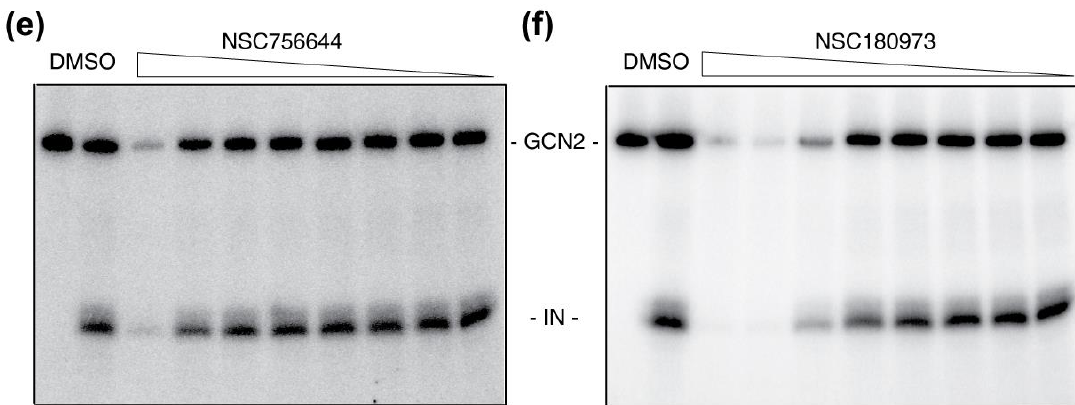
Figure 4. Effect of modulators on GCN2 and IN activities. ( a ) Effect of modulators on IN’s phosphorylation catalyzed by GCN2. Molecules were used at 100 µM corresponding to the initial screen concentration. ( b ) Effect of modulators on GCN2 auto-phosphorylation. The assay was conducted exactly as in panel ( a ) only without IN. Dose-response of active compounds in the phosphorylation assay. Representative images of SDS-PAGE resulting from an in vitro phosphorylation assay of IN catalyzed by GCN2 in the presence of NSC279836 ( c ), NSC758487 ( d ), NSC180973 ( e ), NSC756644 ( f ). First lane corresponds to GCN2 alone while lane two is with IN, both in the presence of DMSO as controls. Lanes three to ten correspond to the conditions with both IN and GCN2 in the presence of decreasing concentrations of molecules from 300 µM to 137 nM, following a 3-fold serial dilution.